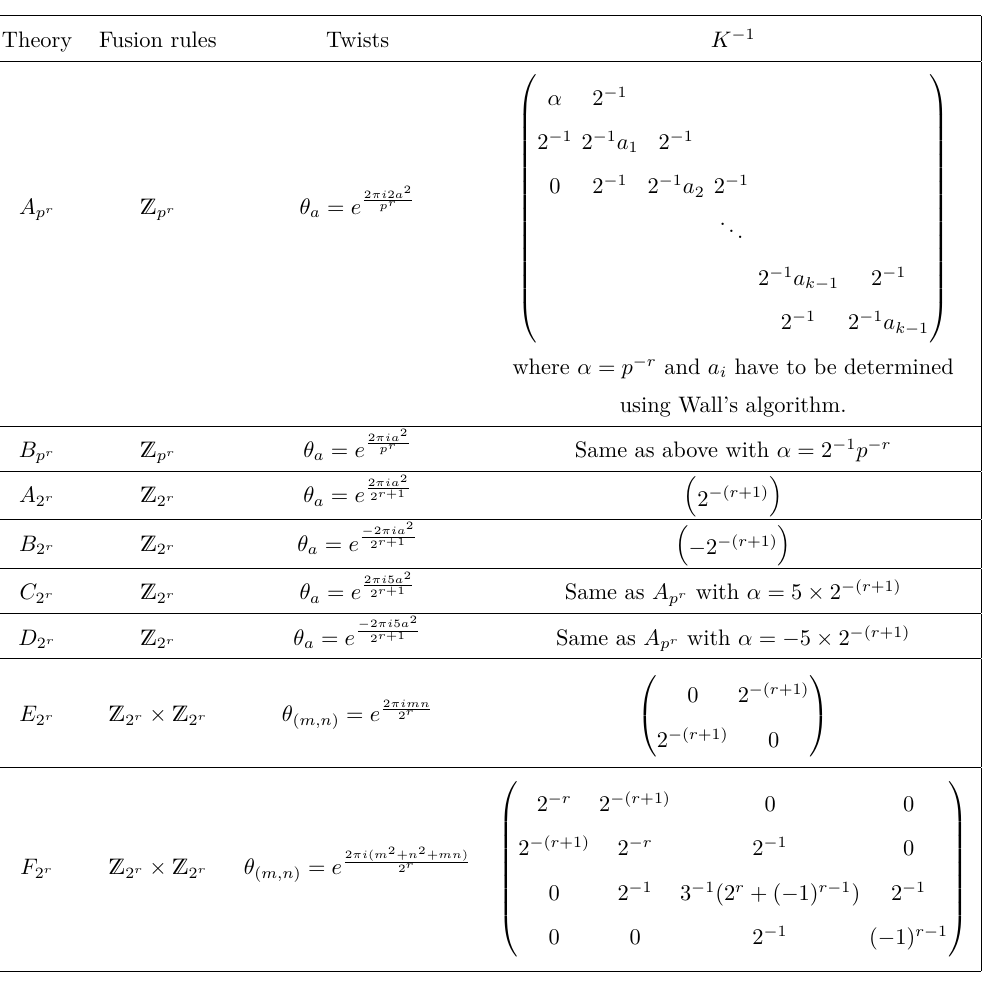
Table 1 . Classification of prime abelian TQFTs and associated K